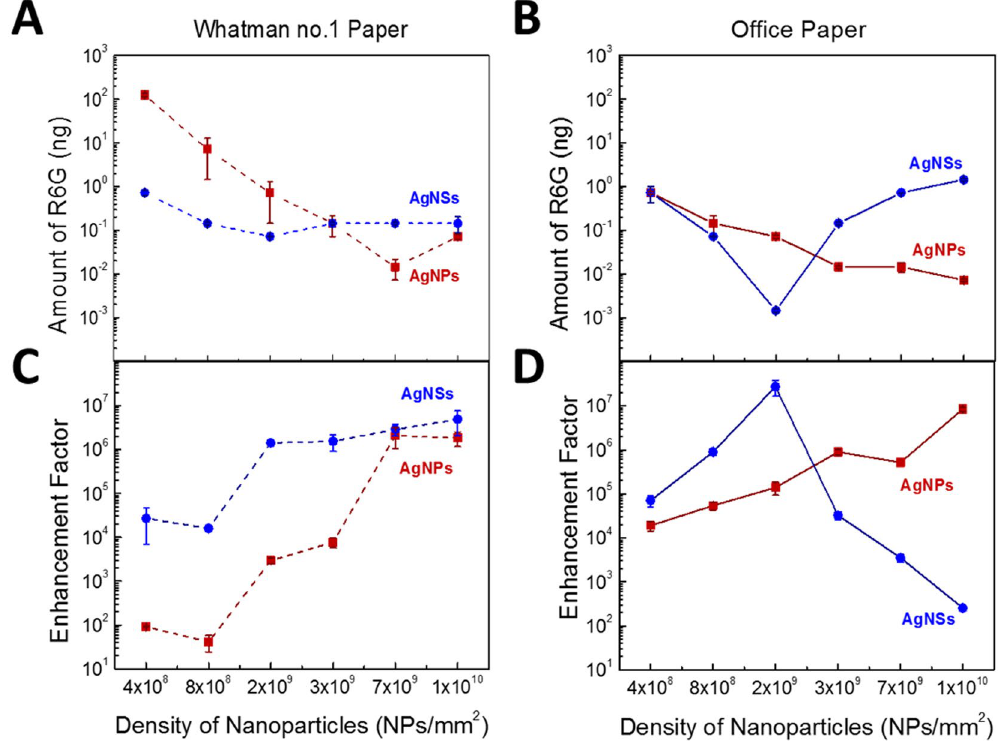
Figure 6. Top : Minimum amount of R6G (in ng) that can be detected on plasmonic substrates prepared on ( A ) Whatman no. 1 paper; and ( B ) office paper. Nanoparticle’ density was calculated by dividing the number of nanoparticles deposited by the area of the well. Data points from AgNPs- and AgNSs-wells are represented by red squares and blue circles, respectively. Bottom: Average EF values for R6G on ( C ) Whatman no. 1 and ( D ) office paper, with several nanoparticles densities. Average EF values were calculated from the 1509 cm − 1 SERS vibrational line. Lines are guides to the